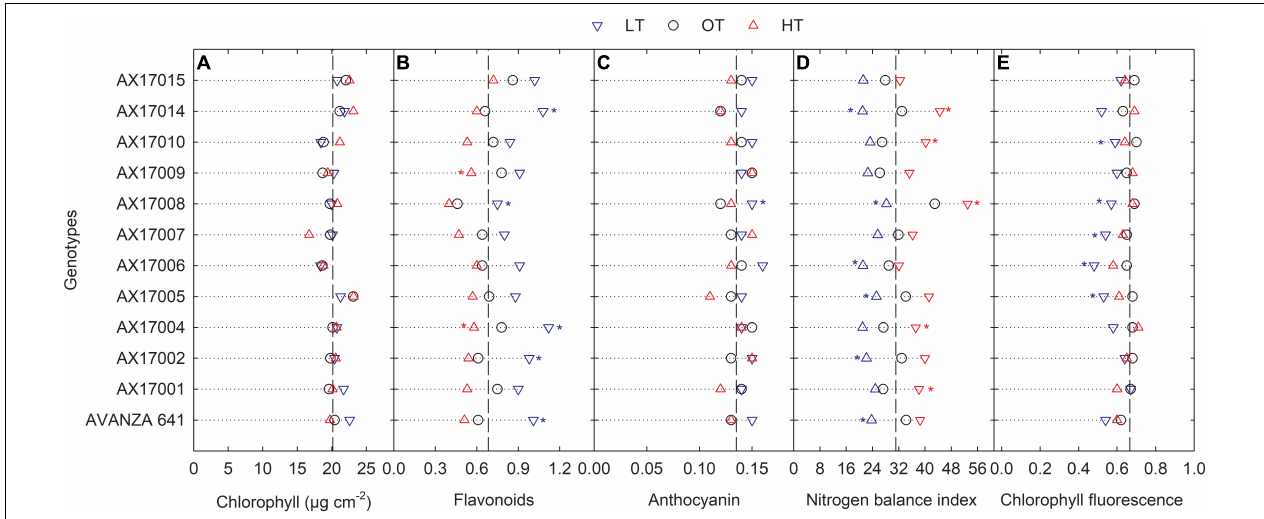
FIGURE 1 | Line plots showing the phenotypic variations in physiological traits such as chlorophyll content (A) , flavonoids (B) , anthocyanin (C) , nitrogen balance index (D) , and chlorophyll fluorescence (E) of 12 advanced Brassica carinata genotypes measured 35 days after planting or 24 days after temperature treatments imposition. The dotted middle line indicates the average trait of 12 genotypes under optimum temperature. LT, low temperature; OT, optimum temperature; and HT, high temperature. Asterisk indicates a significant difference between the temperature treatments (blue – between LT and OT; red – between HT and OT) in a genotype at 5%